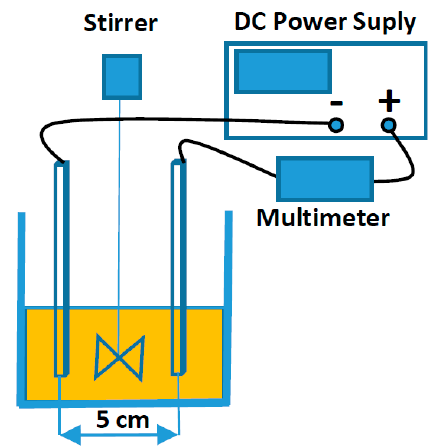
Figure 1. Electrocoagulation (EC) experimental setup of slag leachates processing.